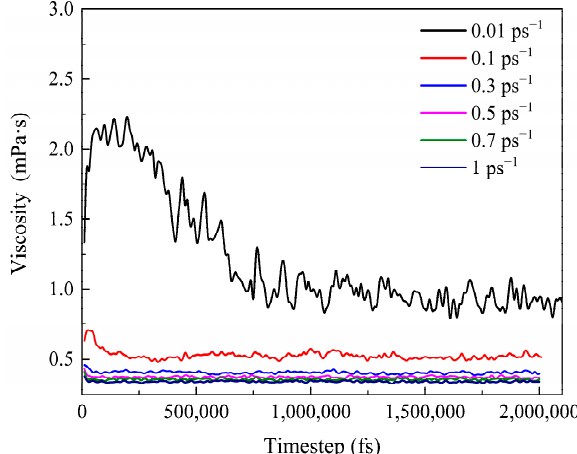
Figure 10. Viscosity of the system at 293.15 K.